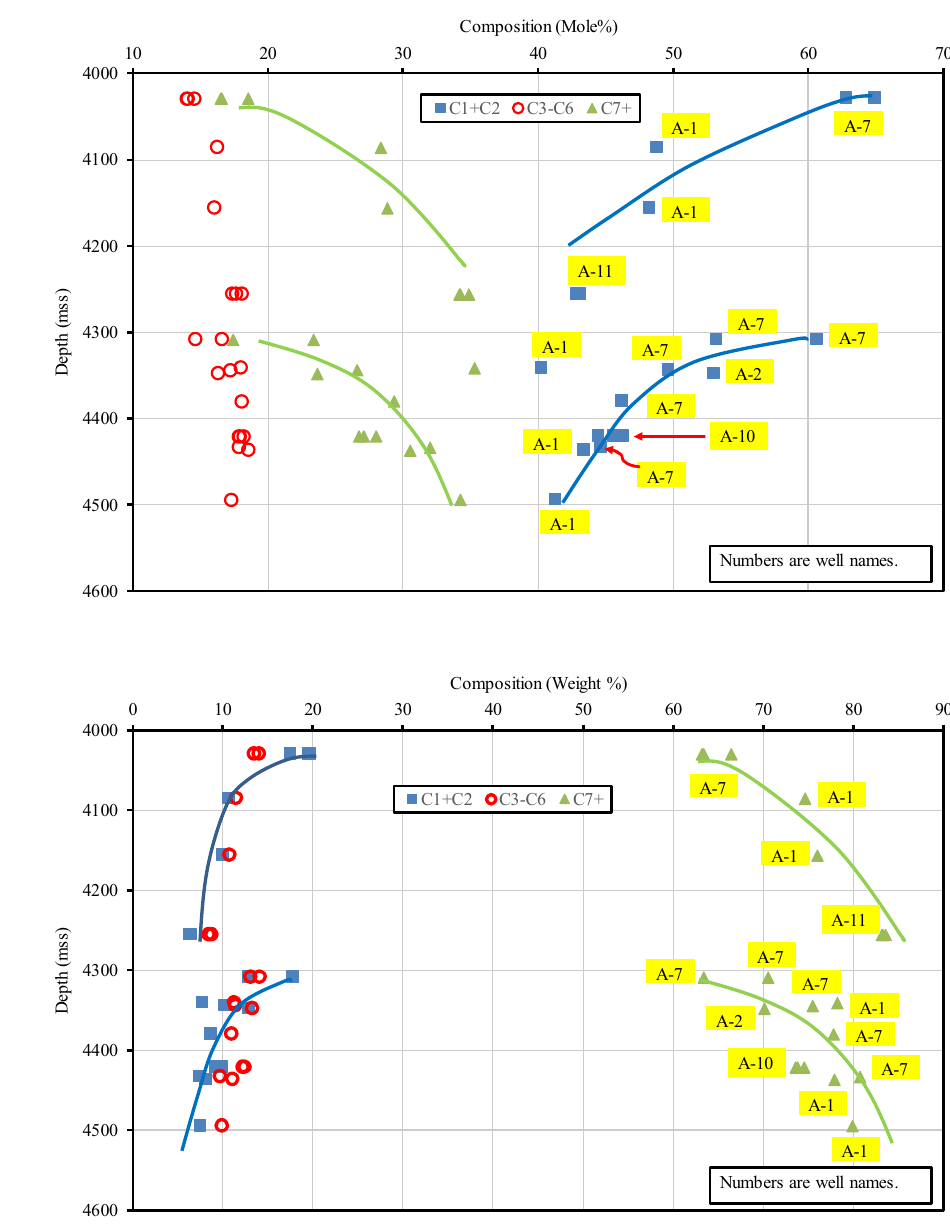
Fig. 5 Vertical reservoir fluid distribution (mole percent)